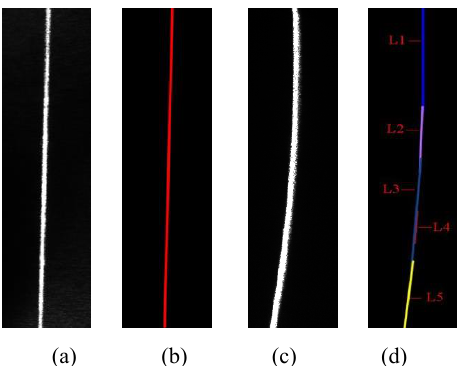
Fig. 14. Demonstration of curving surface detection using Hough algorithm((a): Laser line reflected on flat surface; (b): Hough line detection on (a); (c): Laser line reflected on curving surface; (d): Hough line detection on